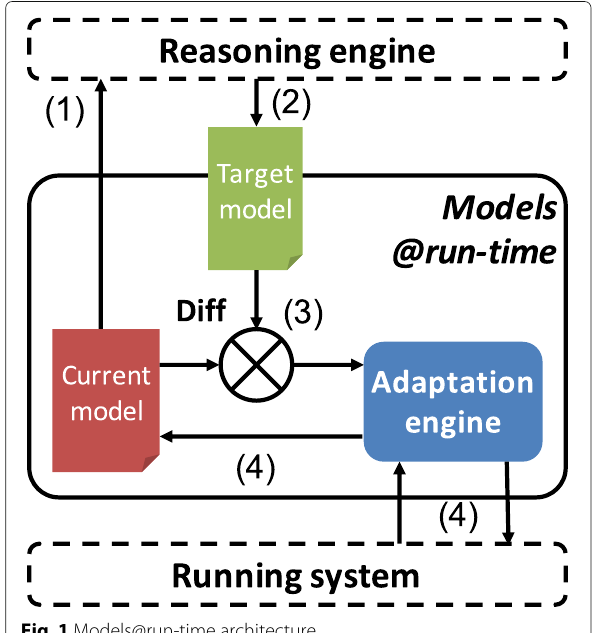
Fig. 1 Models@run-time